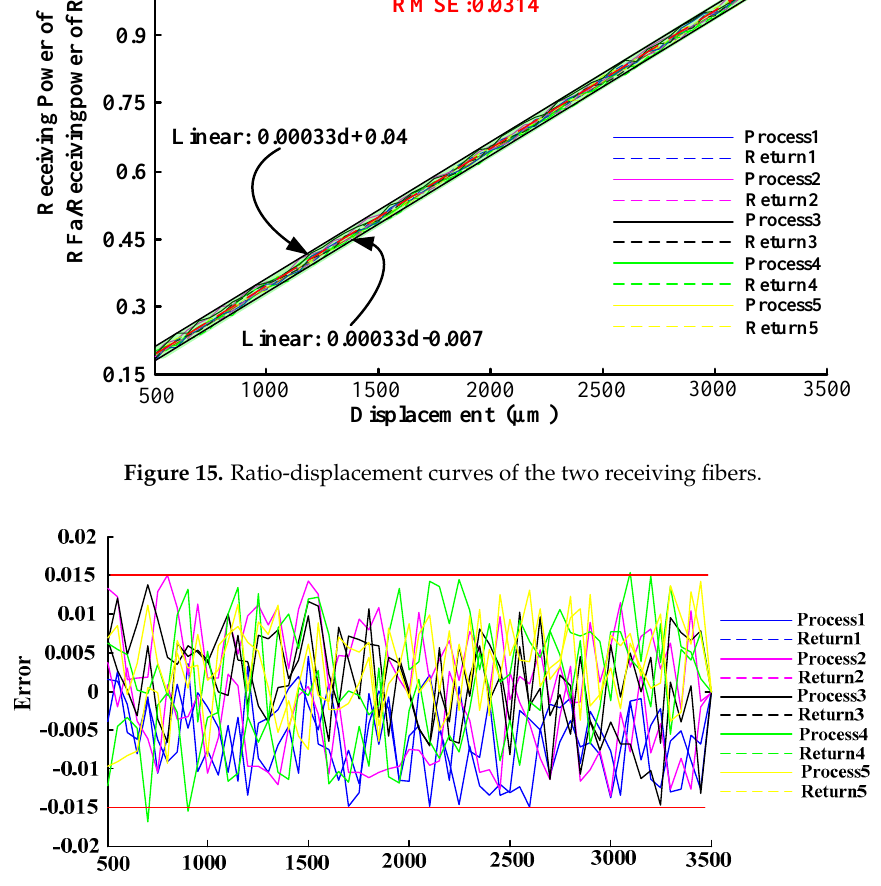
Figure 16. Error of ratio-displacement curve of the two receiving fibers’ deviation from the fitting line.